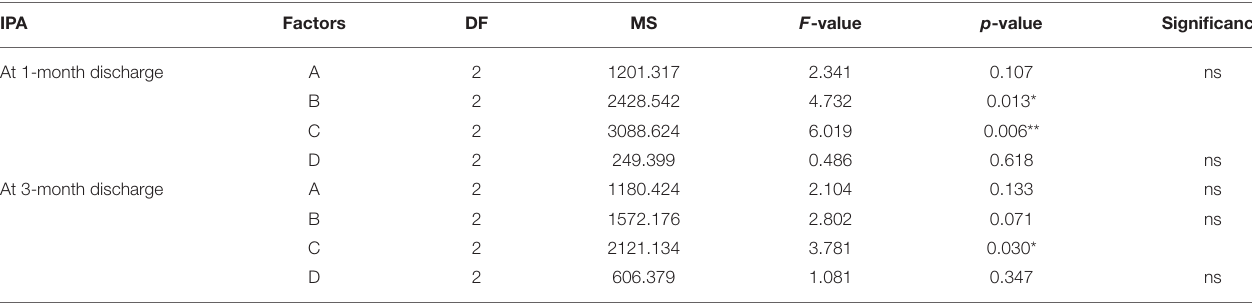
TABLE 11 | ANOVA of the factors affecting social participation. IPA